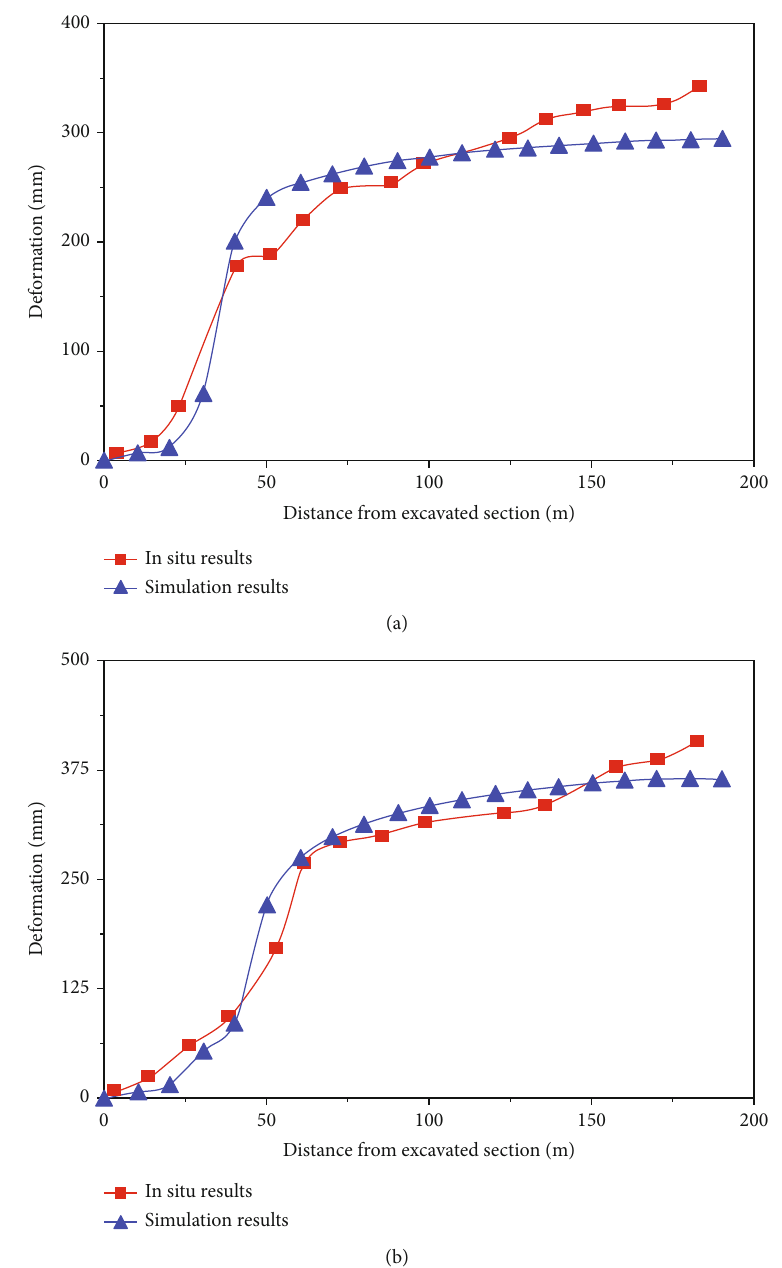
Figure 3: Comparison between numerical simulation results and in situ measurement results of entry deformation: (a) roof-to- fl oor convergence; (b) side-to-side